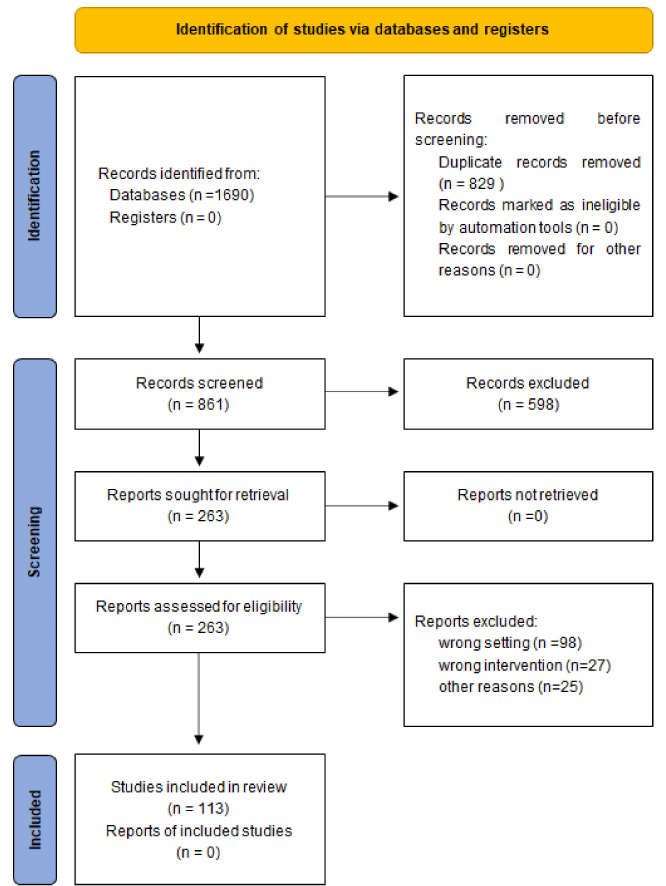
Figure 1. PRISMA Flow Diagram for the identification and screening of the included